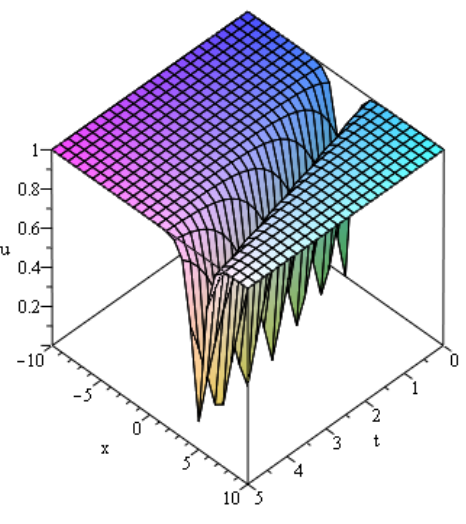
Fig. 3: The obtained soliton solution of Eq. (3) ( | u | ): α = 0.95; k = 2 ; −10 ≤ x ≤ 10;0 ≤ t ≤ 5.